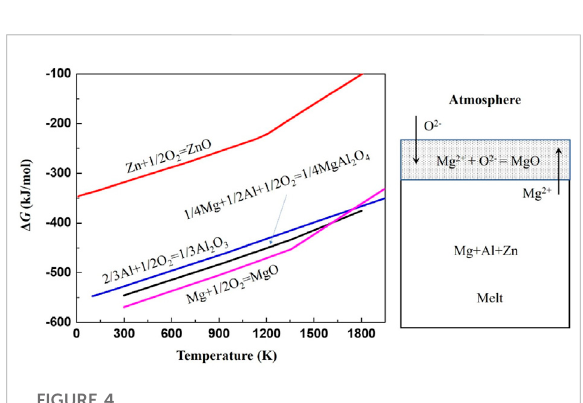
FIGURE 4 The oxidation reaction at the interface of melt/atmosphere and the Gibbus free energies of the formation of